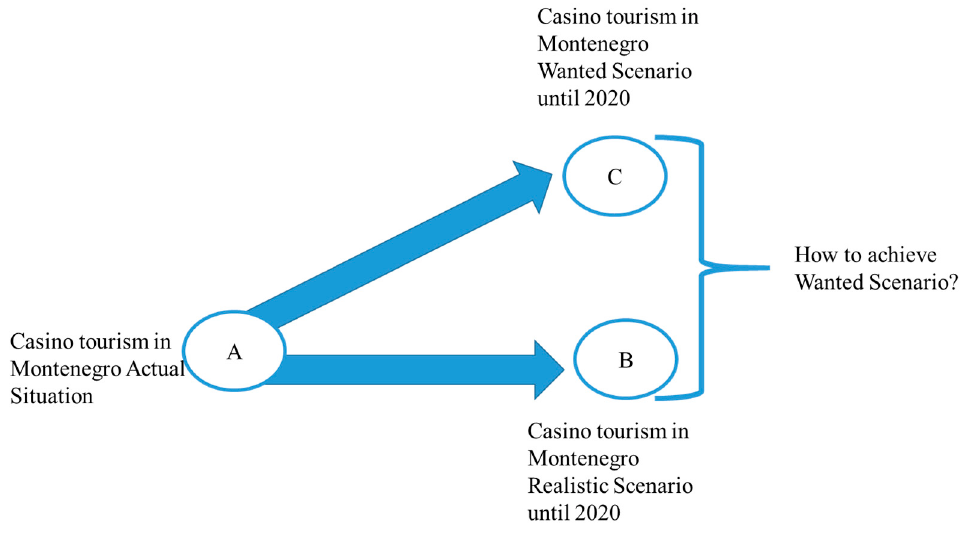
Figure 1. Gap analysis model. Source: Authors.